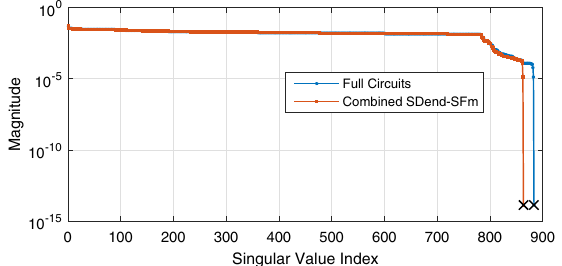
FIG. 3. Singular values of the full sextupole circuit Jacobian and the combined SDend — SFm Jacobian. The marked values were excluded from the fitting procedure.